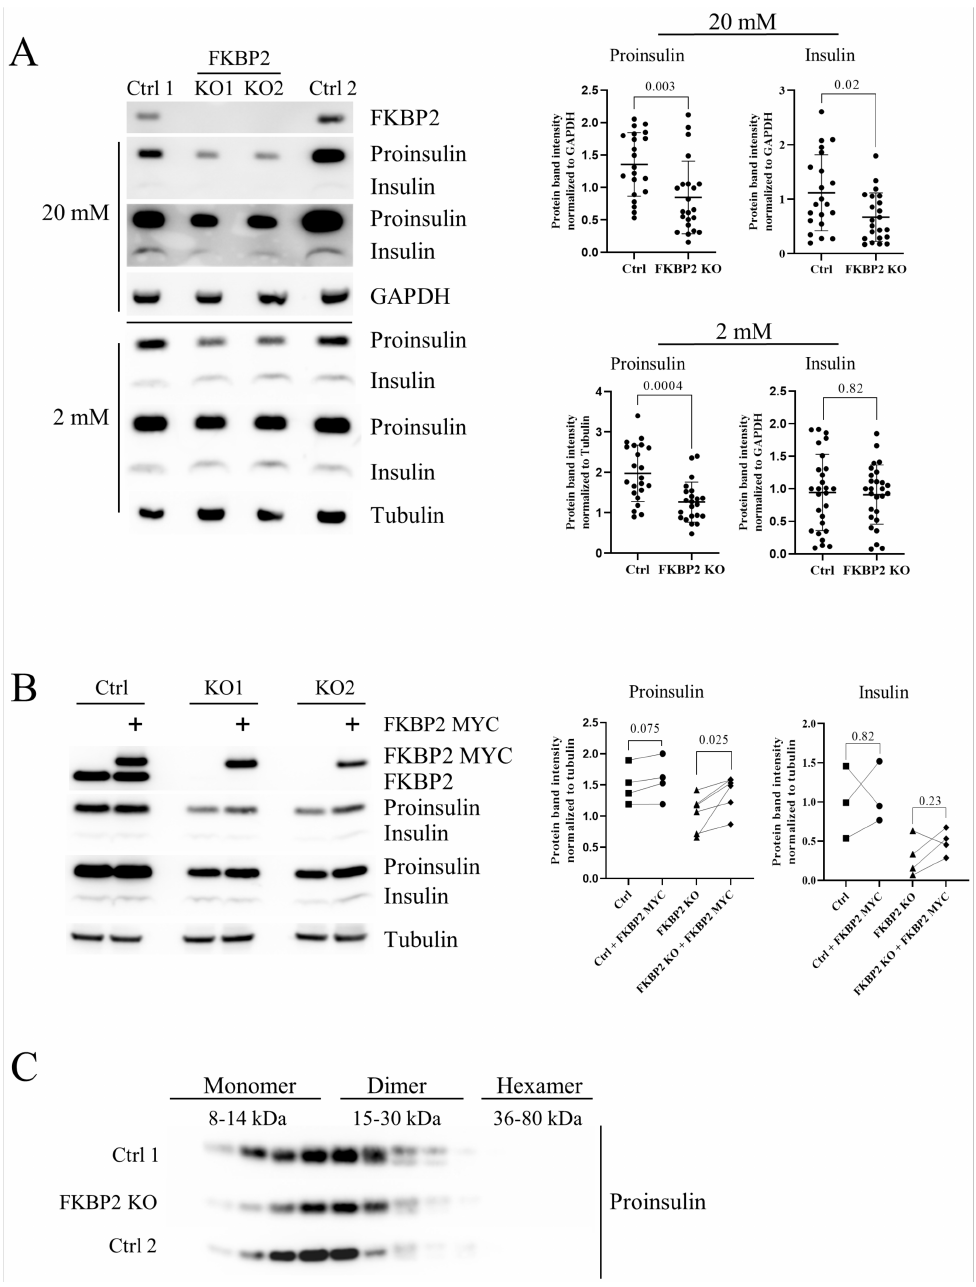
Figure 3. Diminished intracellular proinsulin and insulin contents after FKBP2 KO. ( A ). SDS-PAGE and Western blot analysis of proinsulin and insulin expression levels in FKBP2 KO and FKBP2 WT cells (failed FKBP2 KO and INS1-E) after 2 h in 20 or 2 mM glucose-containing media. FKBP2 KO was achieved via CRISPR/Cas9 guide FKBP2 directed-RNA targeting (clonal cell lines shown 3–6 months after viral transduction; representative blots of n > 10 on the left and band quantification on the